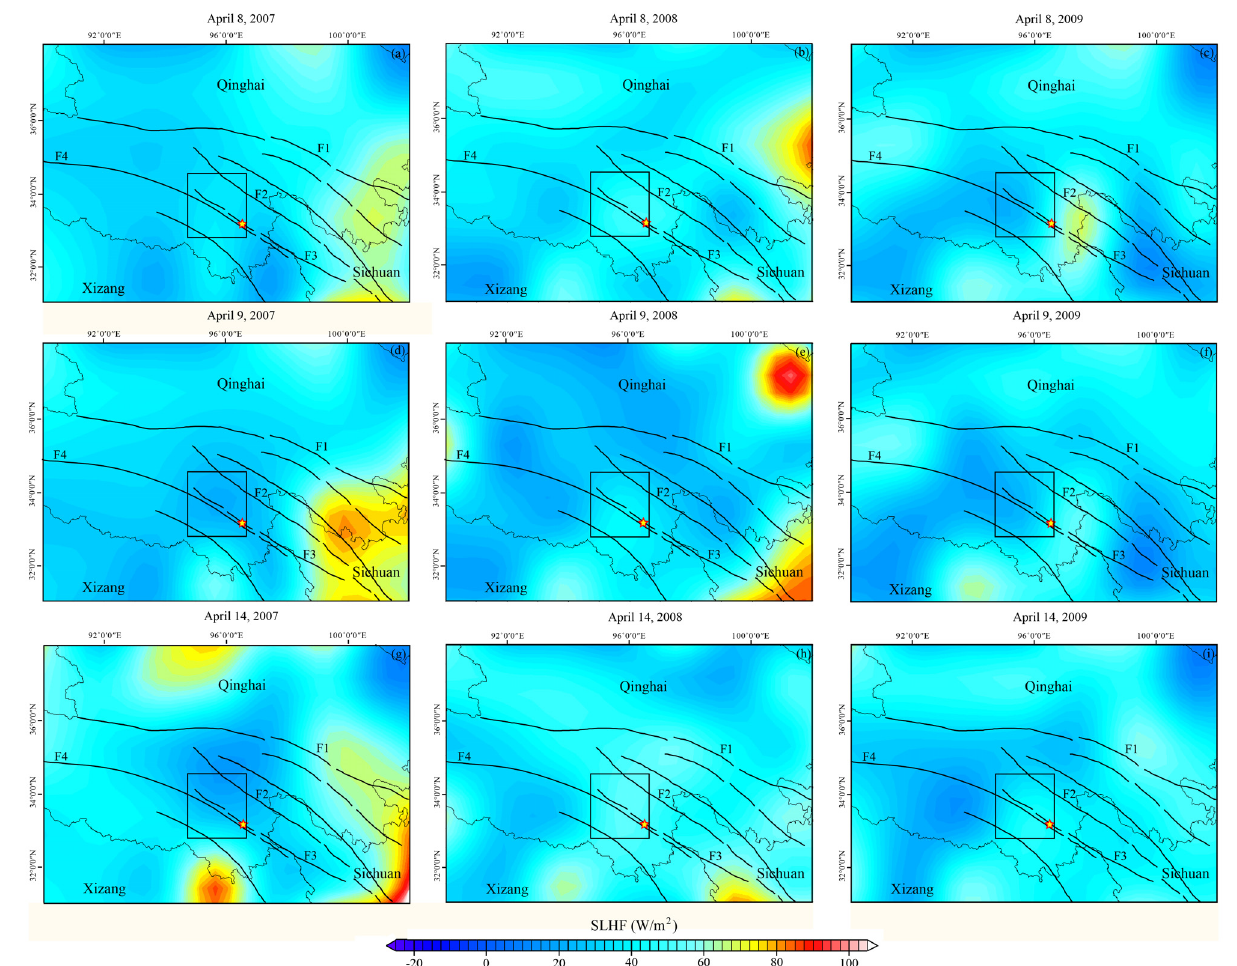
Figure 5. The SLHF images of the daily mean in the Yushu region on April 8, 9 and 14 in the non-earthquake years from 2007 to